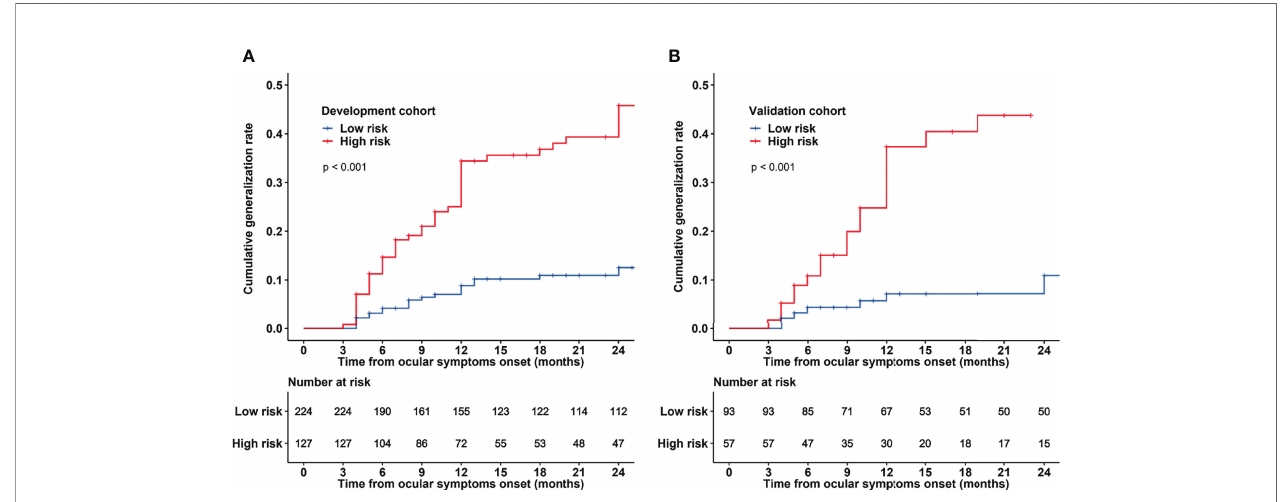
FIGURE 4 | Kaplan − Meier curves for patients with OMG based on risk group strati fi cation in the development and validation cohorts. Patients were strati fi ed into low- and high-risk generalization groups based on the optimal cut-off value (26%). Two-year cumulative generalization rates are presented for the development cohort (A) and validation cohort (B) .